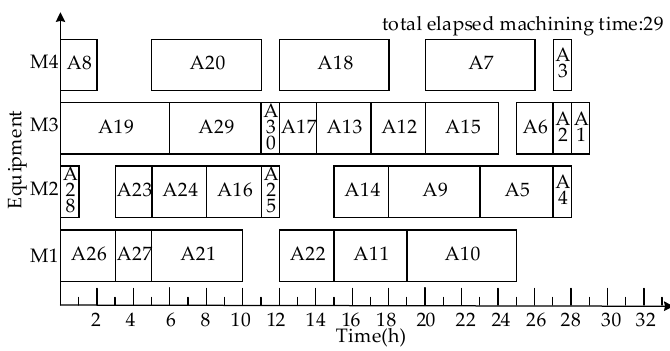
Figure 9. Gantt chart of scheduling A using MISAR.